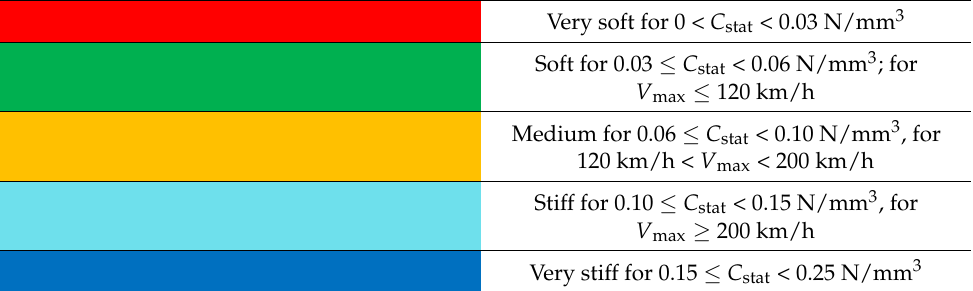
Table 5. Coloristic identification of UBM types based on the values of static bedding modulus, according to DIN 45673-5